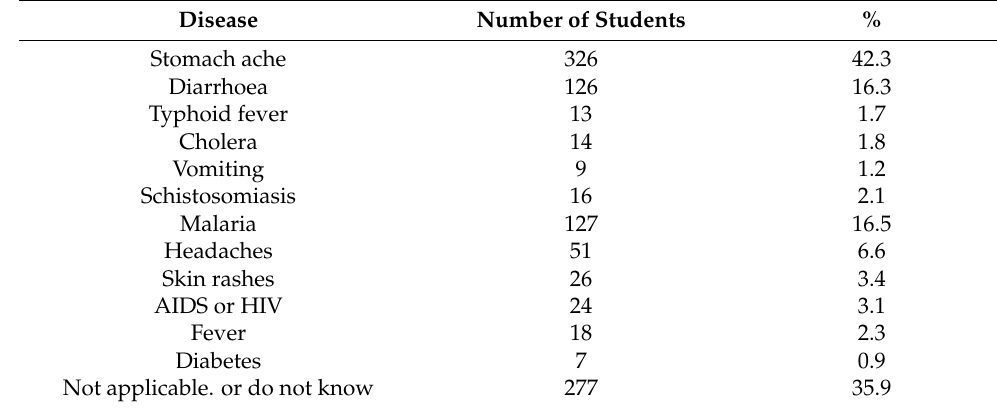
Table 4. The student’s answers to the question of which diseases are caused in relation to lack of water or contaminated water. Disease Number of Students